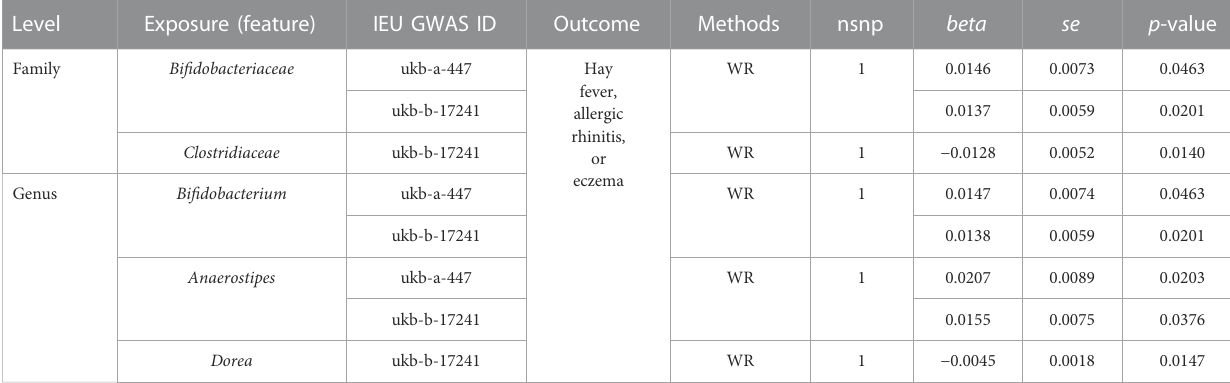
TABLE 2 Signi fi cant 2SMR analysis results between gut microbiome composition and hay fever, allergic rhinitis, or eczema.